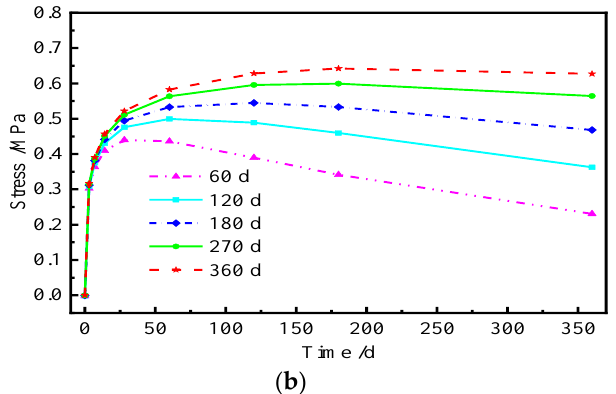
Figure 22. Time-varying interfacial stress. ( a ) With the shear cogging. ( b ) Without the shear cogging.